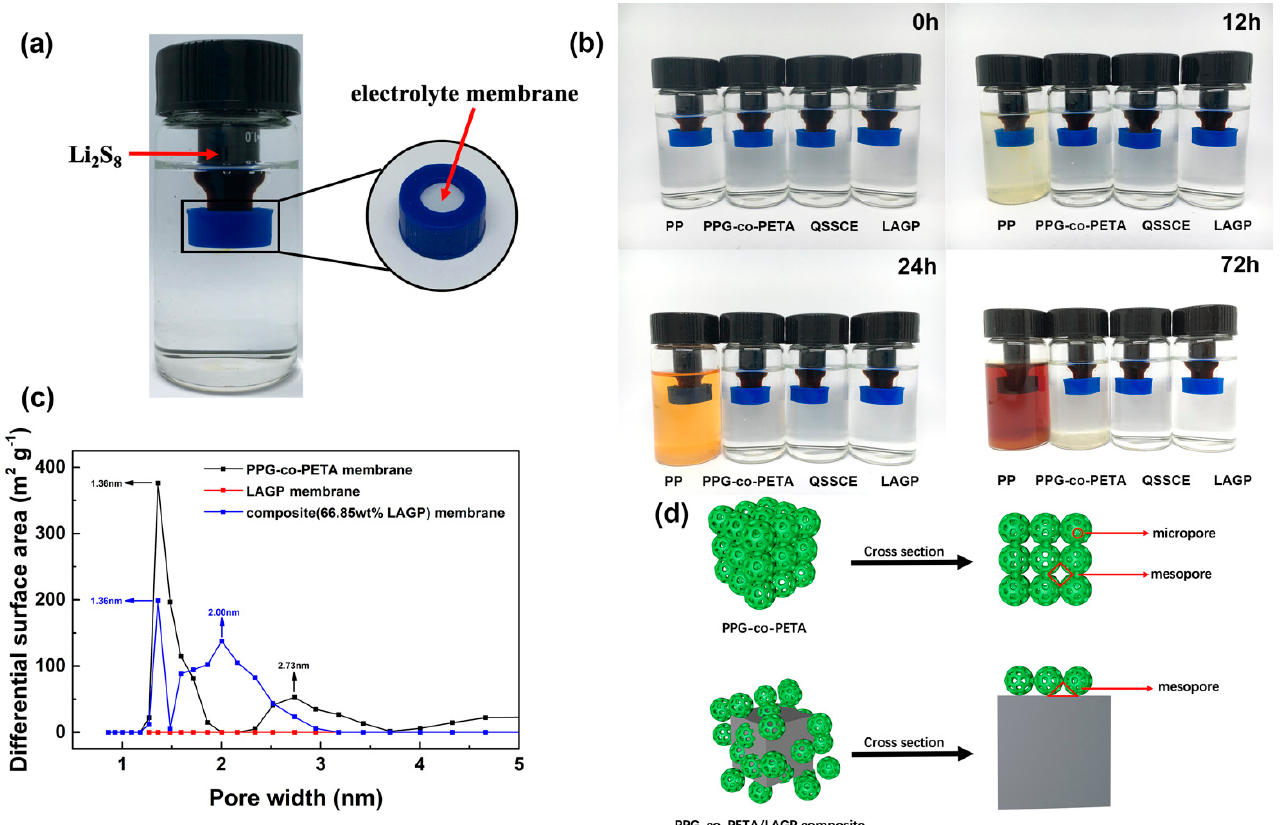
Figure 5. ( a ) The self-made device for characterizing the ability of polysulfides’ shuttle effect. ( b ) The polysulfides’ diffusion test of PP, PPG-co-PETA, QSSCE and LAGP at different times. ( c ) The pore size distribution curves of PPG-co-PETA, QSSCE and LAGP. ( d ) The schematic drawing of the micropore and mesopore structure of the PPG-co-PETA and PPG-co-PETA/LAGP composites.